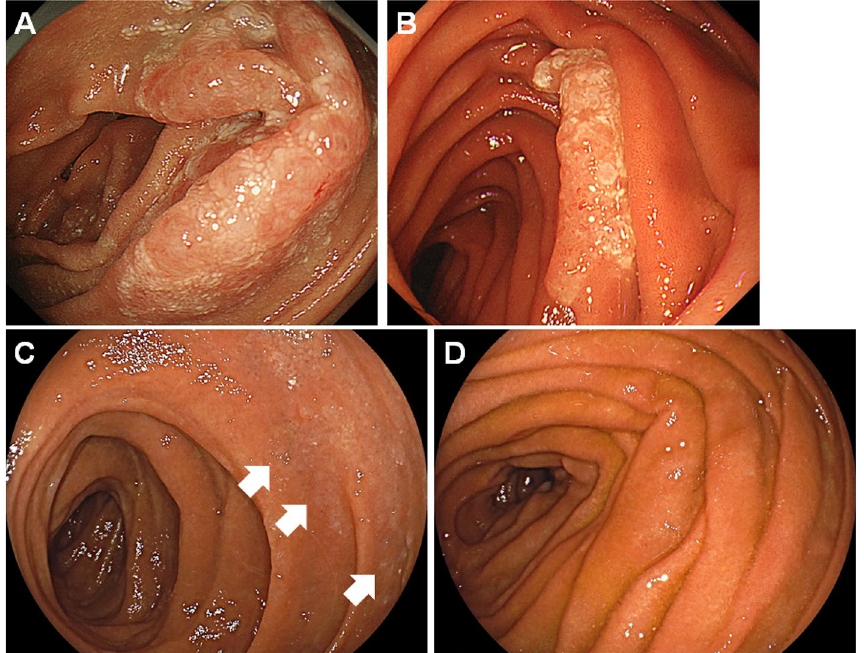
Figure 2. Representative endoscopic images of a case showing spontaneous regression of duodenal follicular lymphoma. A duodenal lesion showing whitish villi was detected in a 63-year-old woman ( A ). The area of the whitish lesion reduced 4 years after the diagnosis ( B ). The whitish lesion became faint 6 years after the diagnosis ( C ). The duodenal lesion disappeared and no lymphoma cells were detected on biopsied specimen 7 years after the diagnosis ( D